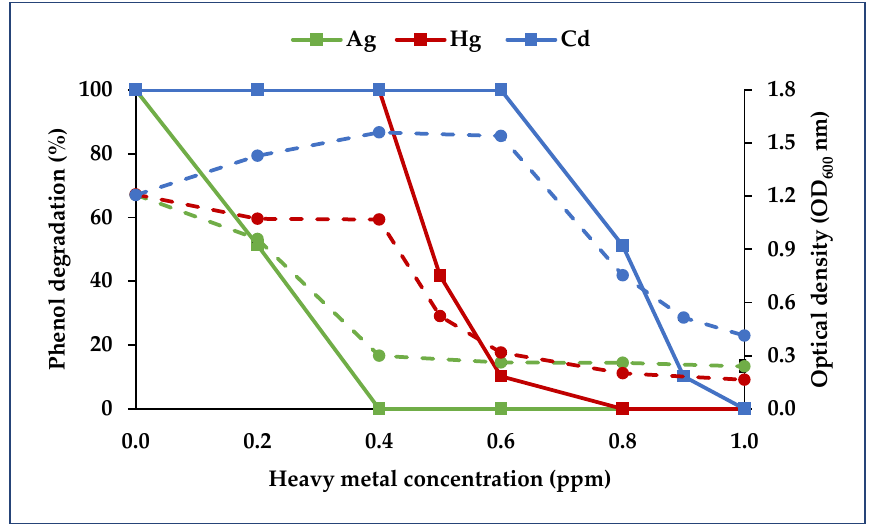
Figure 11. The influence of exposure to different concentrations of Ag, Hg and Cd on phenol degradation (solid line) and the growth (dotted line) of the binary consortium.